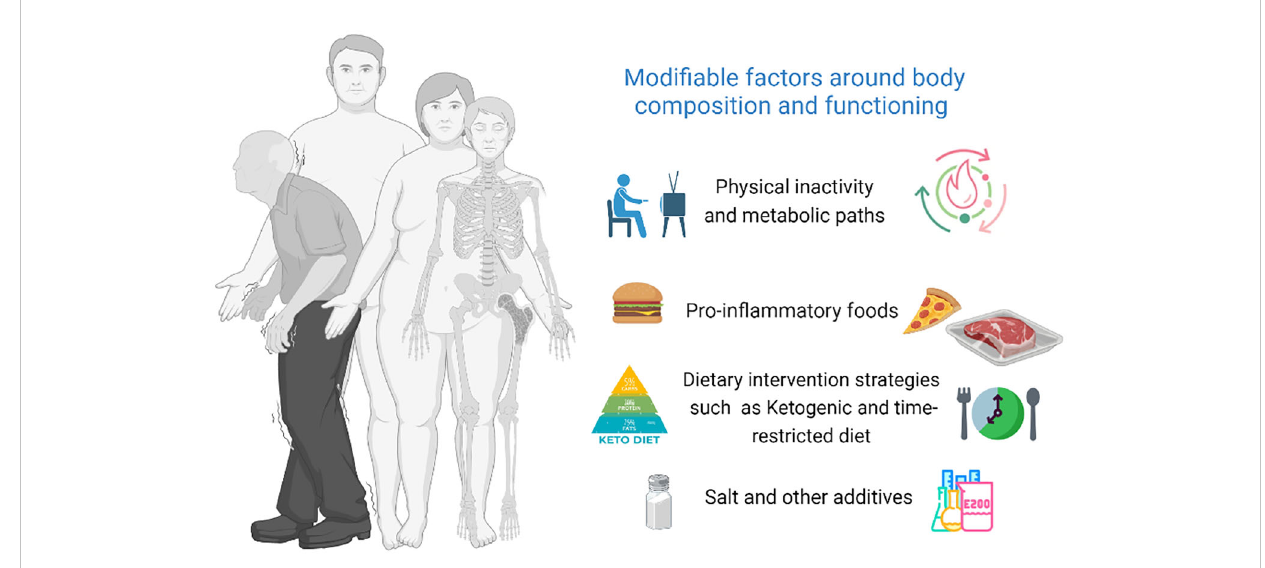
FIGURE 1 Graphical abstract of the Research